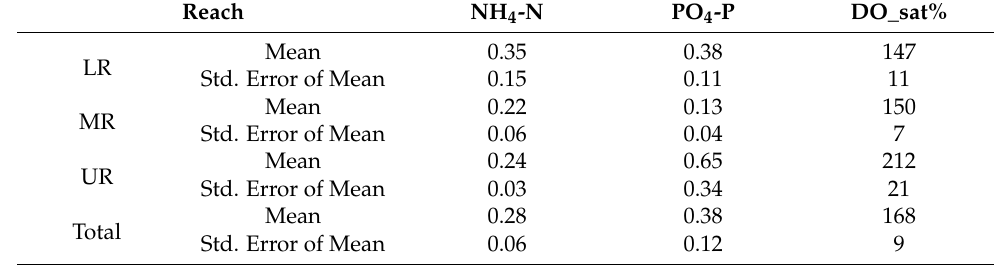
Table 1. Water quality indices across reaches in the Gumara River. LR—lower reach, MR—middle reach, UR—upper reach.